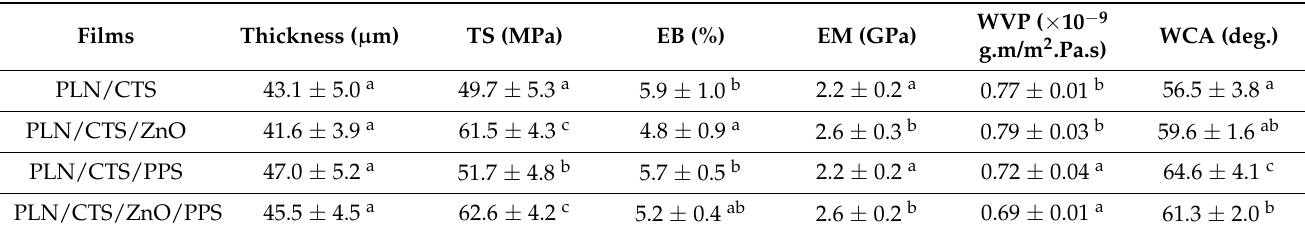
Mechanical properties, water vapor permeability, and water contact angle of pullulan/chitosan-based bioactive